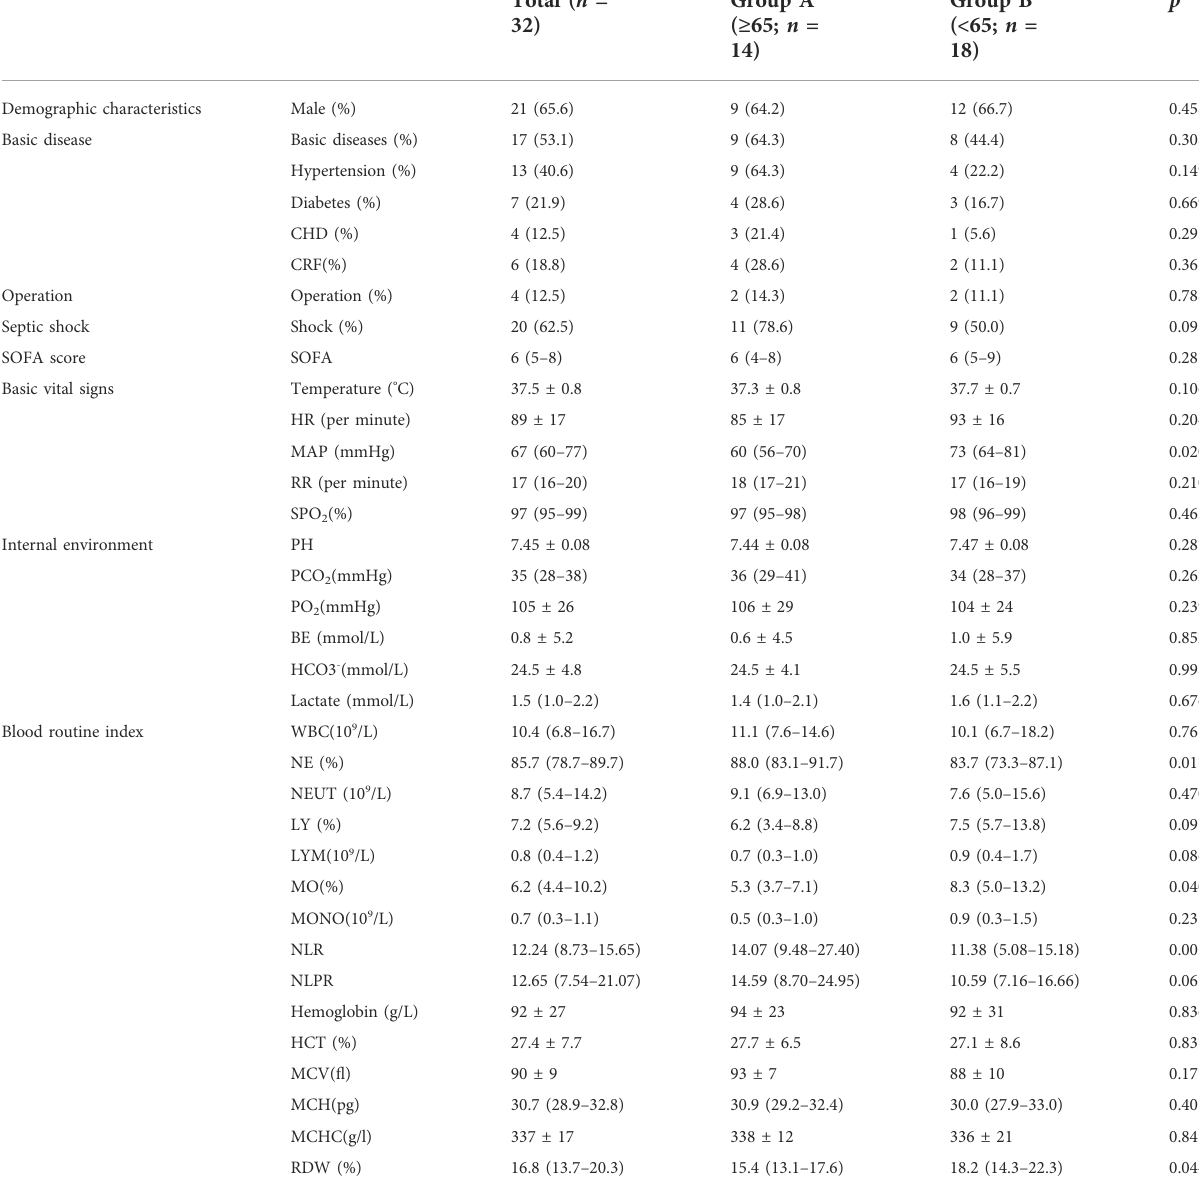
TABLE 1 Basic clinical characteristics of patients with abdominal sepsis in different age